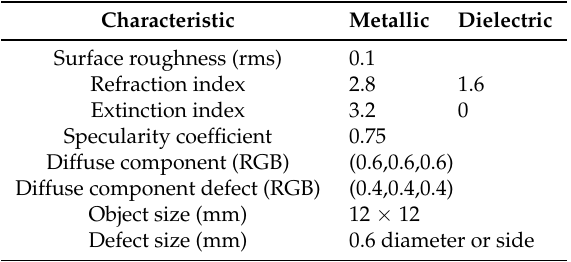
Table 1. Characterists of the objects to be generated in the